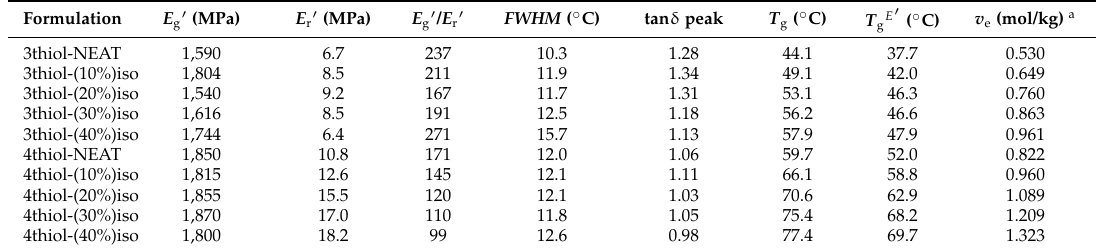
Table 2. Network structure and thermo-mechanical properties of the different materials of study.